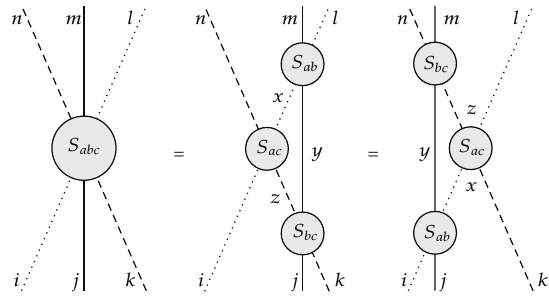
Figure 4: Factorization of the three-body S-matrix and Yang-Baxter